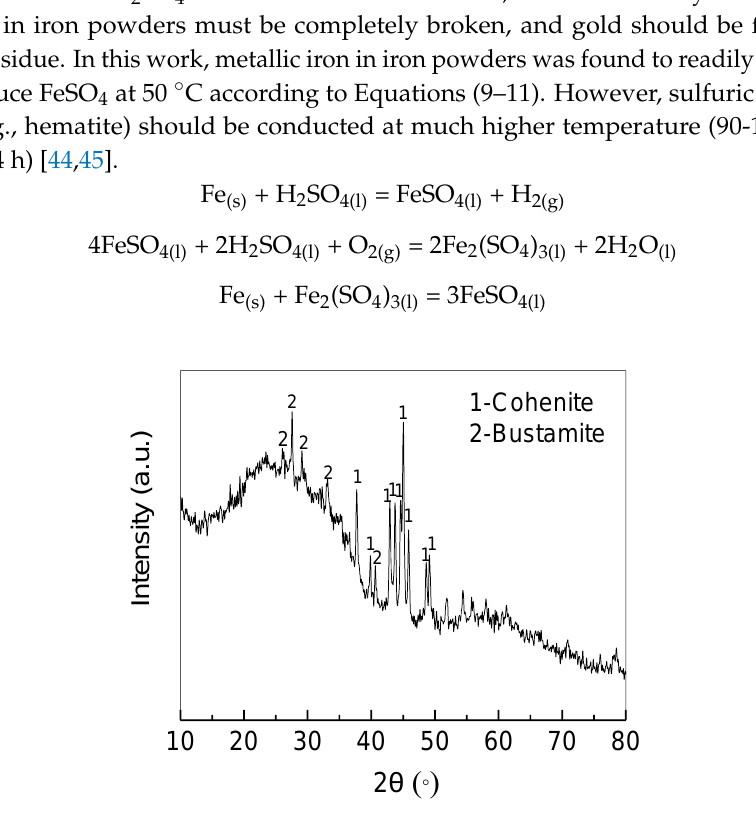
Figure 10. XRD pattern of acid-leaching residue.